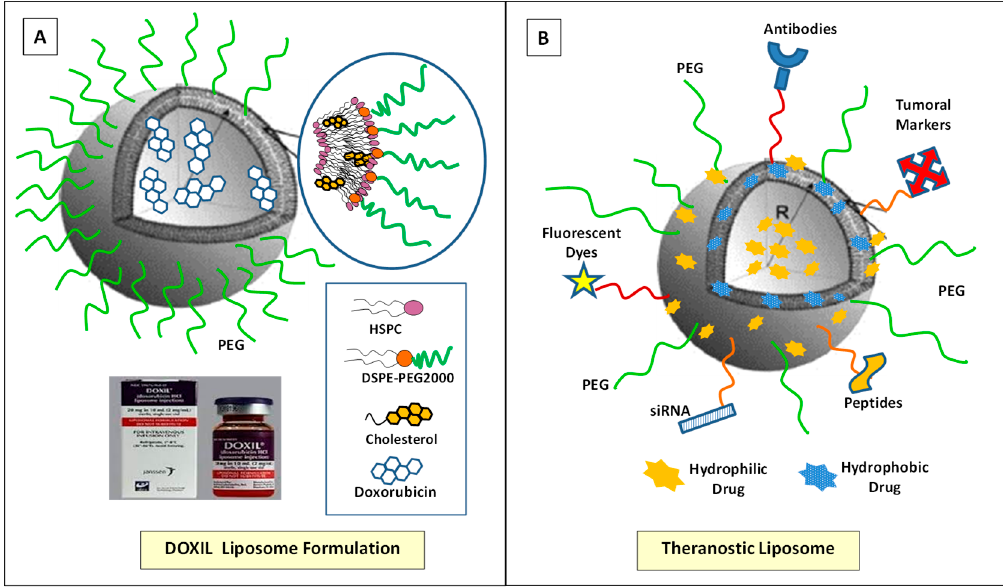
Figure 14. Main characteristics of the anticancer drug Doxil ( A ). Liposomes functionalization with various ligands, (peptides, fluorescent dyes, antibodies, aptamers, tumoral markers) and improvement of the specificity of the liposome interaction with target tissues (targeted drug delivery) ( B ).